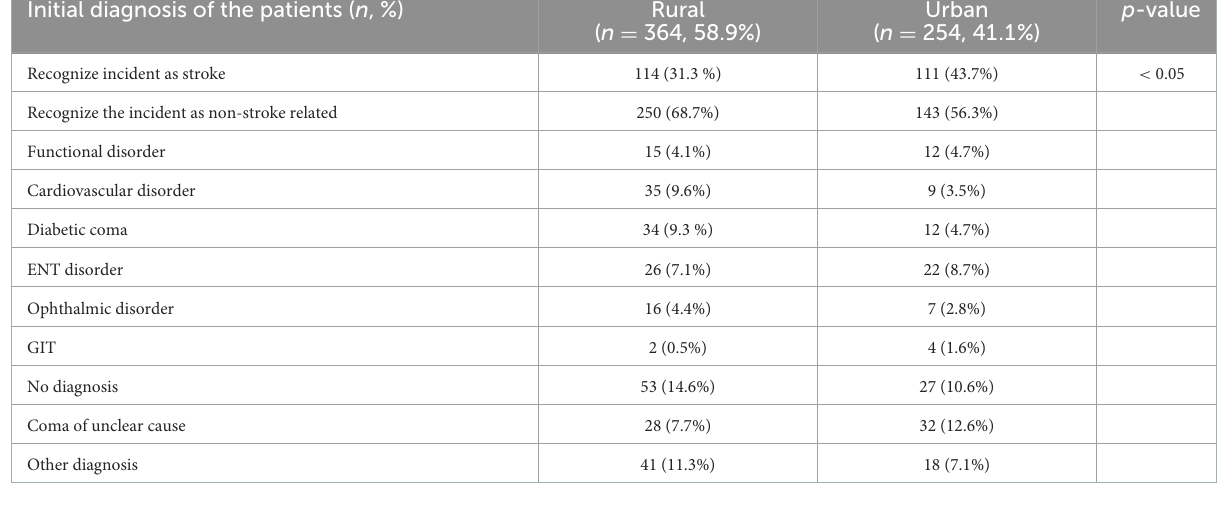
p -value Urban ( n = 364, 58.9%) ( n = 254, 41.1%)